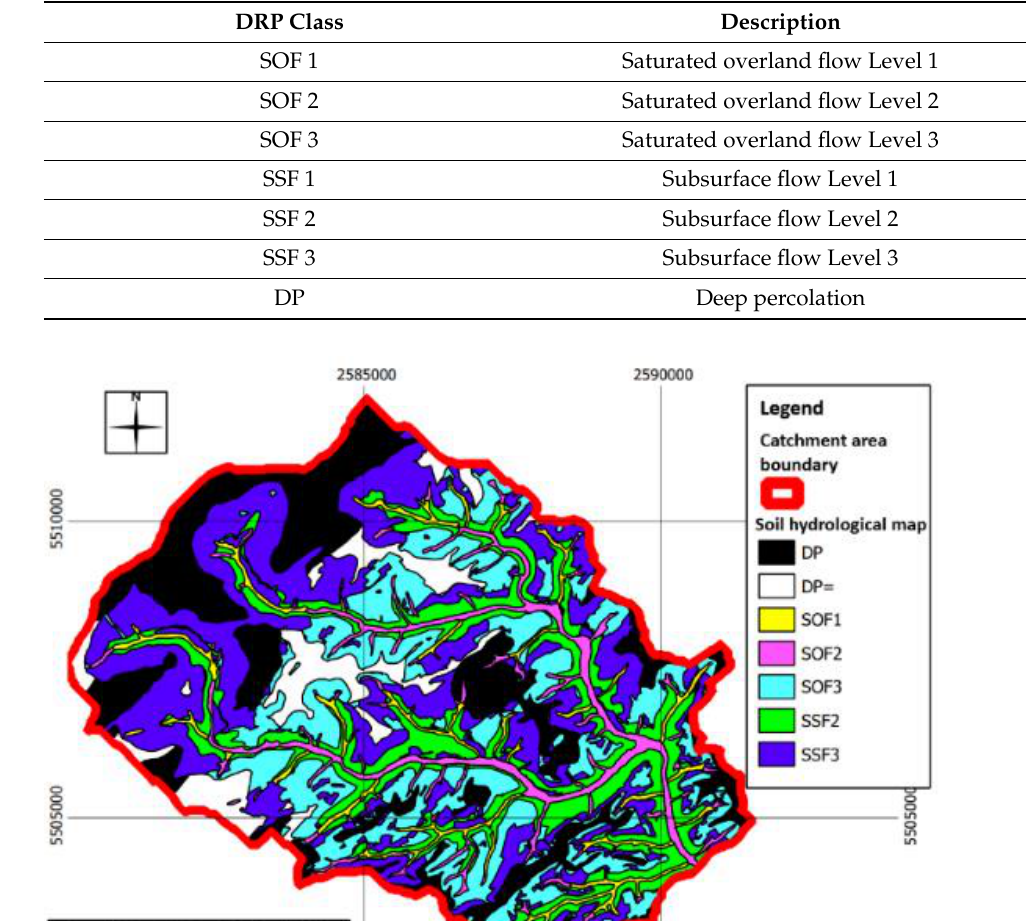
Table 3. List of the DRP classes defined in the reference soil hydrological map [32,44].